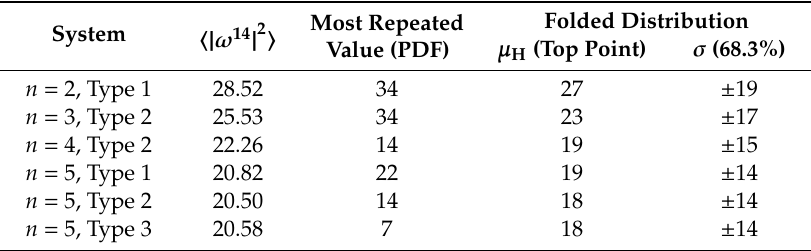
Table A15. Statistical parameters of SAW size for the BCC restricted lattice as a function of system characteristics (fixed: N = 14) for selected